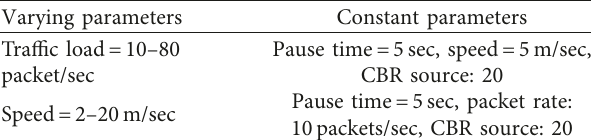
Table 2: Scenario variations.